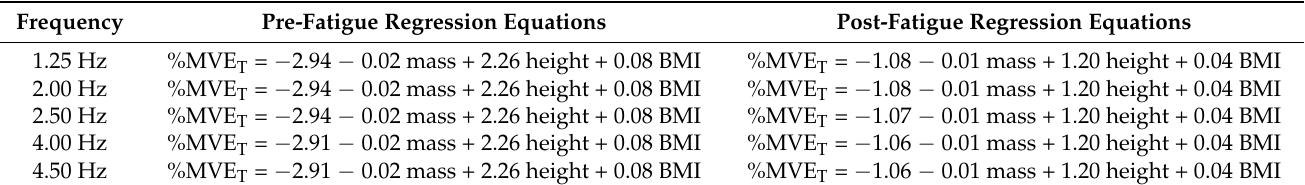
Figure 5. Fits vs. %MVE T (transformed % maximum voluntary electrical activation data) ( a ) before and ( b ) after back muscle fatigue from the stepwise regression models of the lumbar erector spinae (LE). Table 5. Stepwise regression models for %MVE T (transformed % maximum voluntary electrical activation data) of the lumbar erector spinae pre- and post-back muscle fatigue, where mass, height, and body mass index (BMI) are continuous predictors, and vibration frequency is a categorical